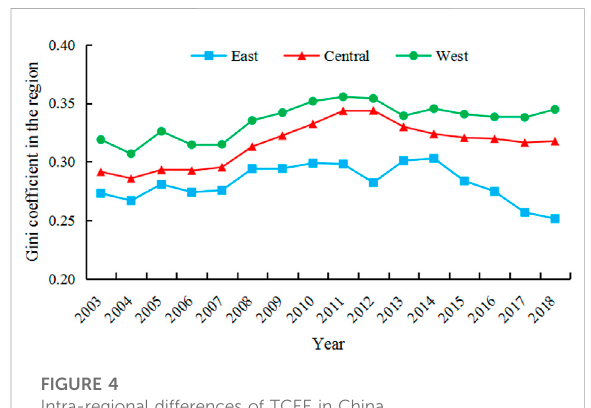
FIGURE 4 Intra-regional differences of TCEE in China.